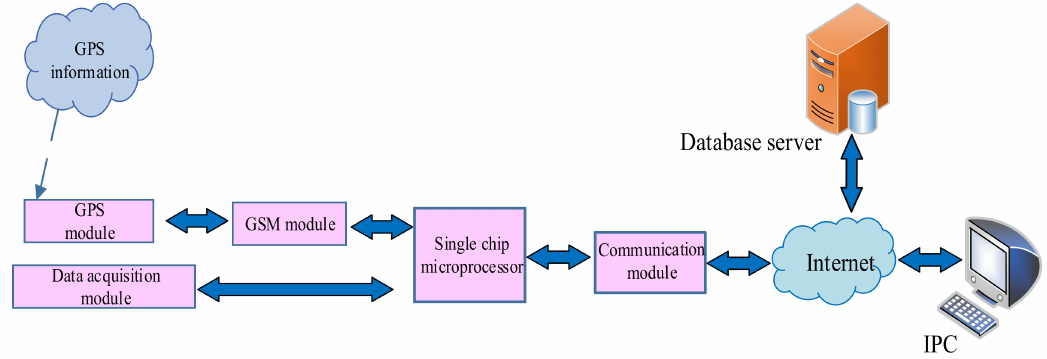
Figure 2. Overall structure diagram of a detection